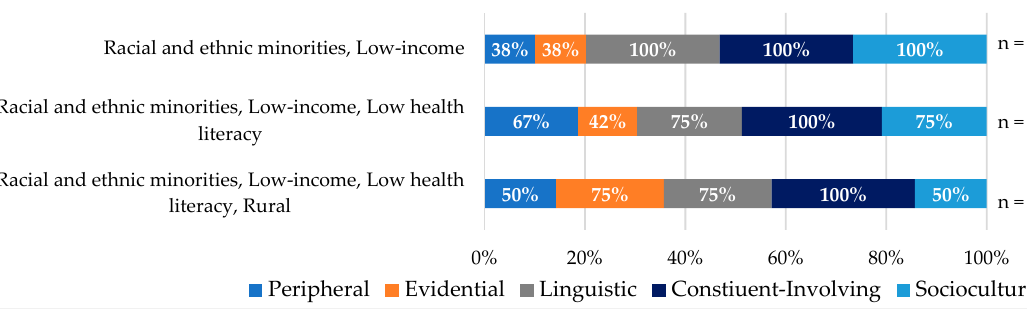
Figure 5. Cultural tailoring use and intersectionality.